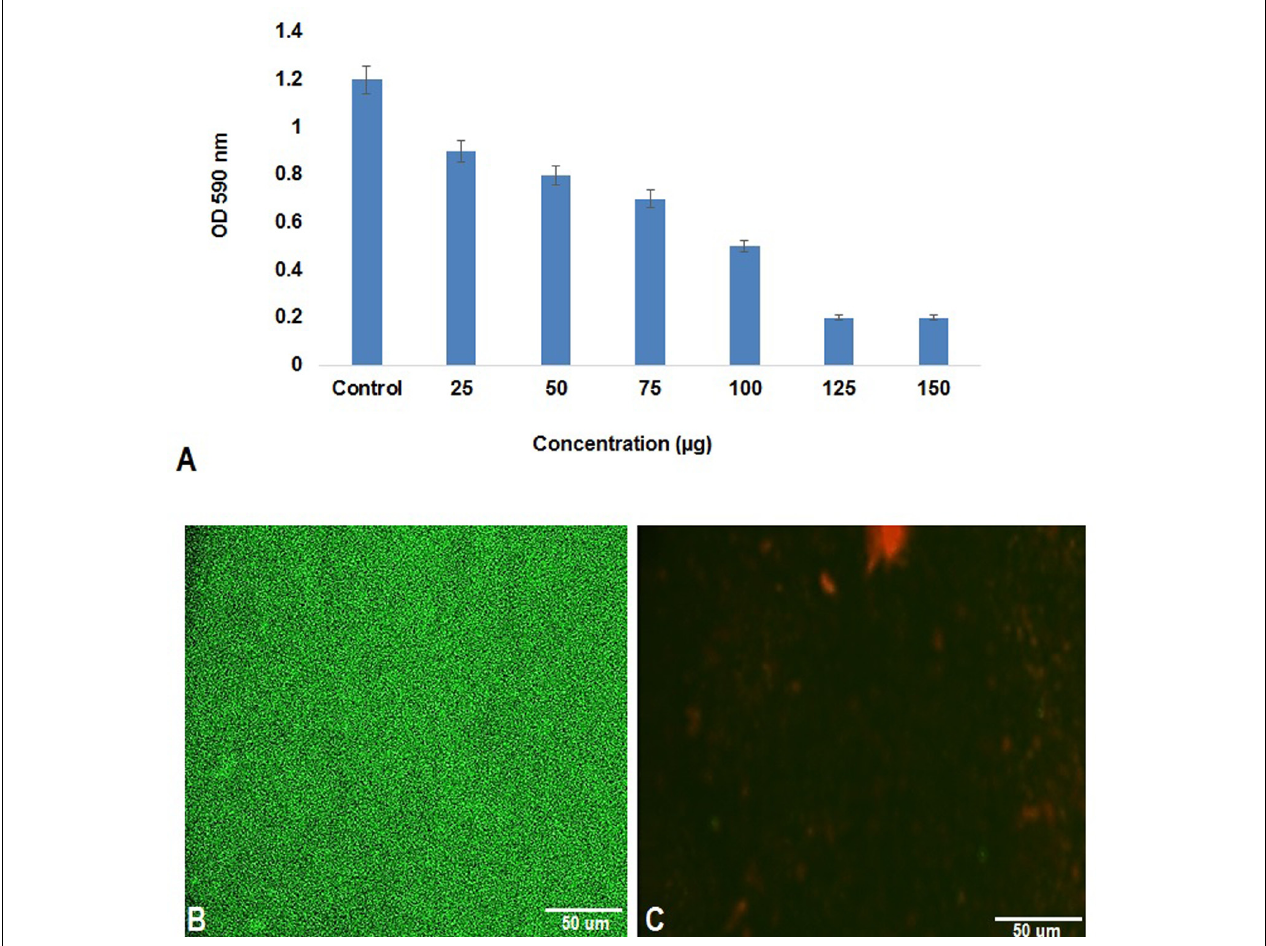
FIGURE 5 | Antibiofilm activity of lipopeptide MSA31 against MDR pathogen S. aureus . (A) Microtitre assay showing antibiofilm effect of Lipopeptide. (B) Is a control biofilm and (C) lipopeptide treated biofilm visualized by baclight